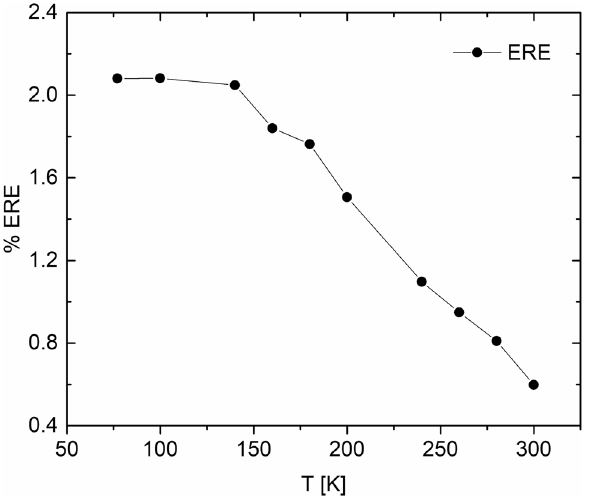
Figure 5. A plot of ERE vs T for the solar cells discussed here. The data are means values across a field of view of ≈ 3.5 mm × 3.5